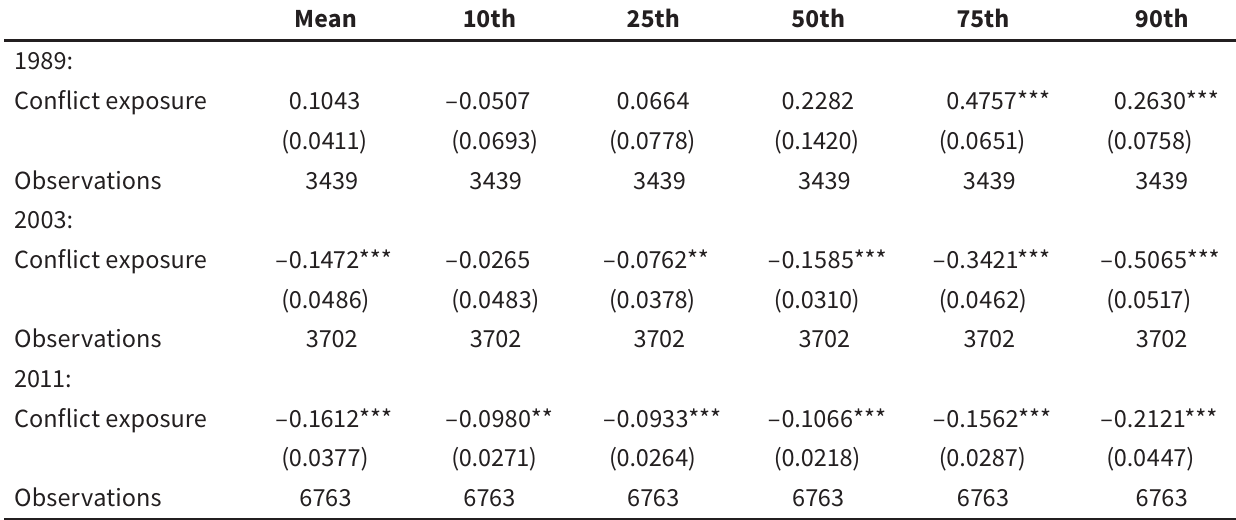
Table A2.15 OLS and Quantile Treatment Effects using Log Household Expenditure – Interaction between Main Conflict Exposure measure and Conflict Deaths per Chiefdom Above